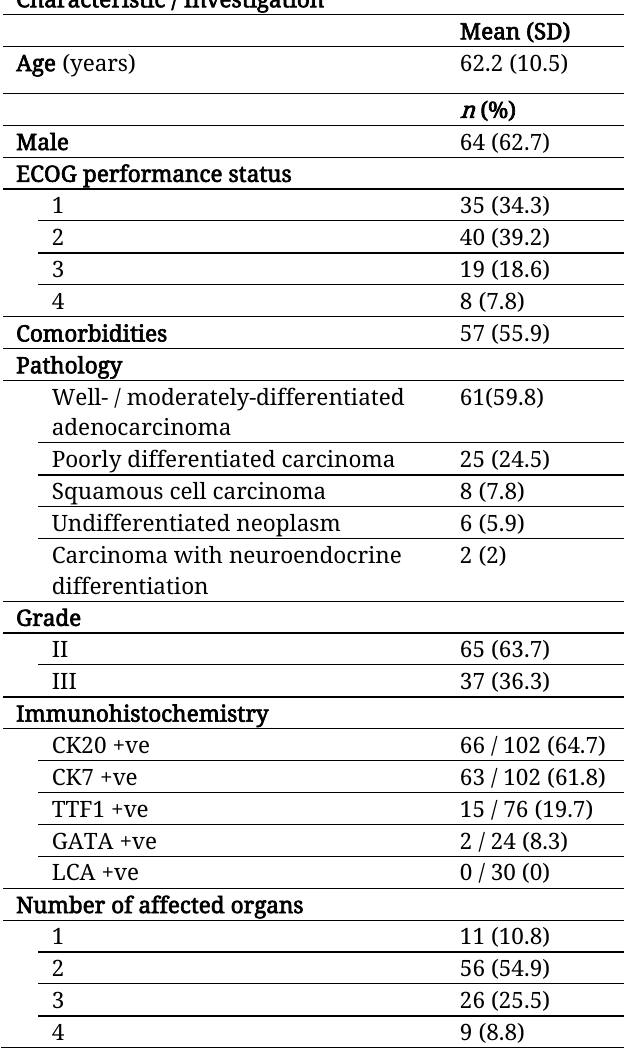
Table 1: Characteristics of 102 patients with cancer